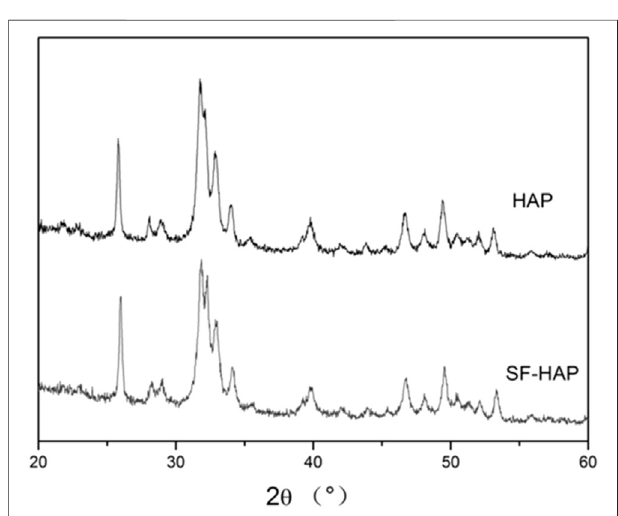
FIGURE 4 | XRD patterns of the pure HAp and SF/nHAp composites.